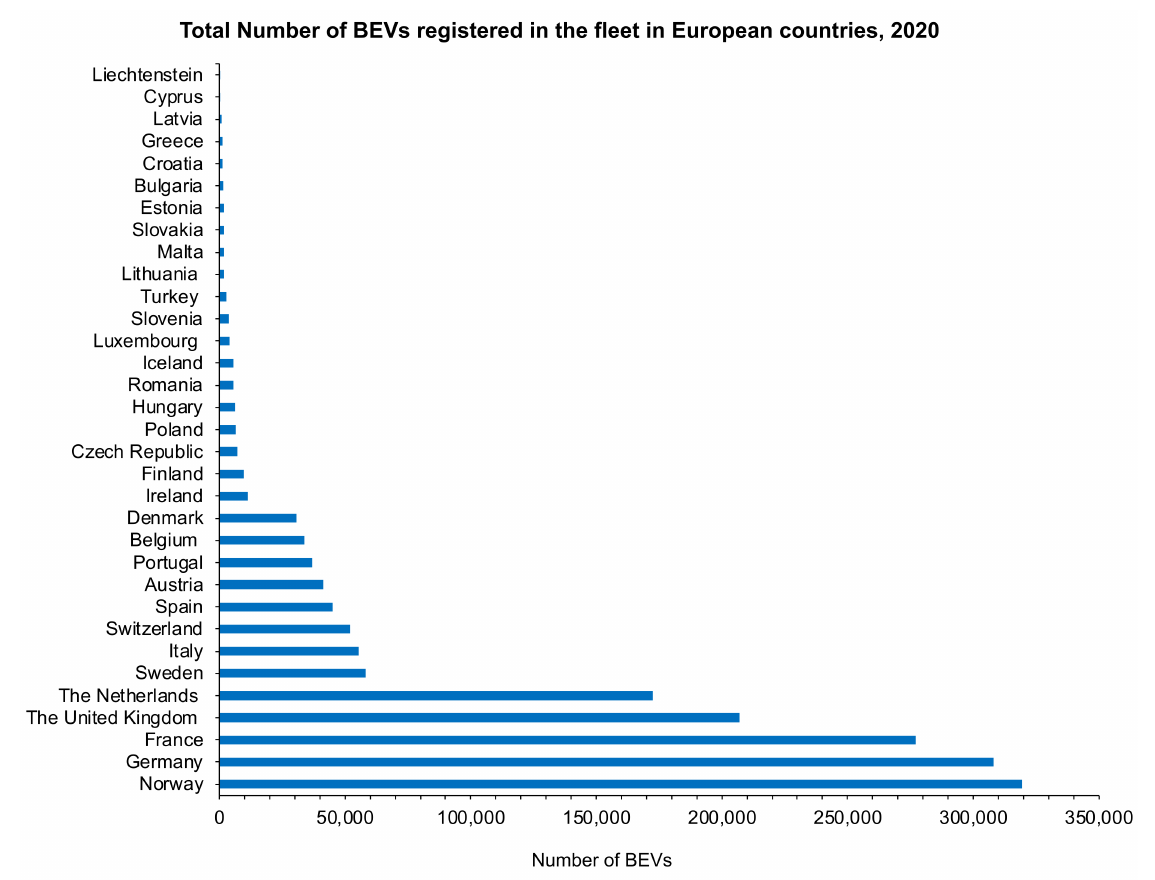
Figure 2. Number of BEVs registered in the fleet in European countries in 2020. This figure was created with data from European Alternative Fuels Observatory (EAFO)